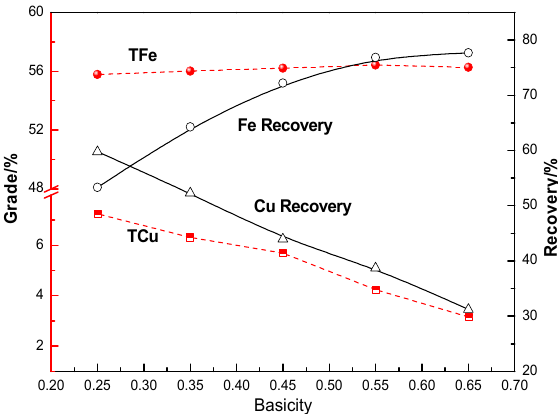
Figure 5. Effects of binary basicity on recovering of copper and iron (Modifying at 1350 °C for 120 min with 6% of compound additive and cooling at 1.5 °C/min from 1350 to 900 °C).